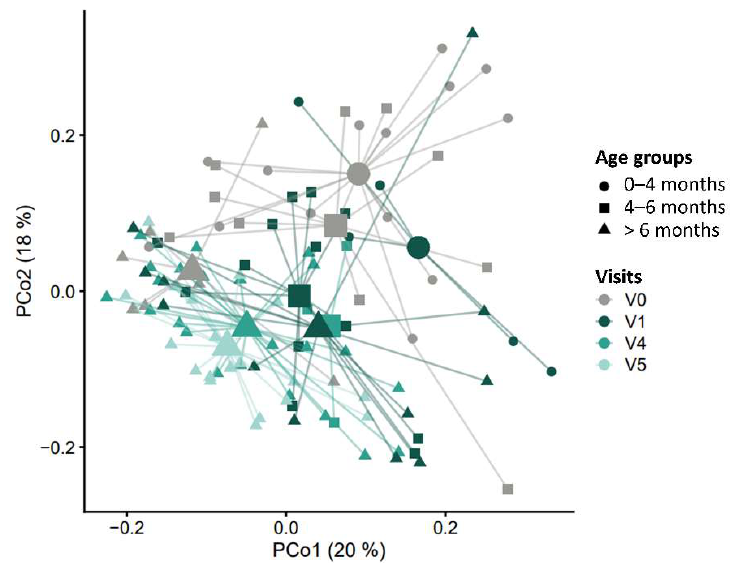
Figure 5. Beta diversity plot. The principal coordinates analysis (PCoA) shows weighted UniFrac distances among samples for study visits V0, V1, V4, and V5. The mean (centroid) of samples in each group is indicated with a larger shape. Each sample is connected to its centroid by a thin line. The X - and Y -axis labels indicate the microbial variance explained by the first two principal coordinates.